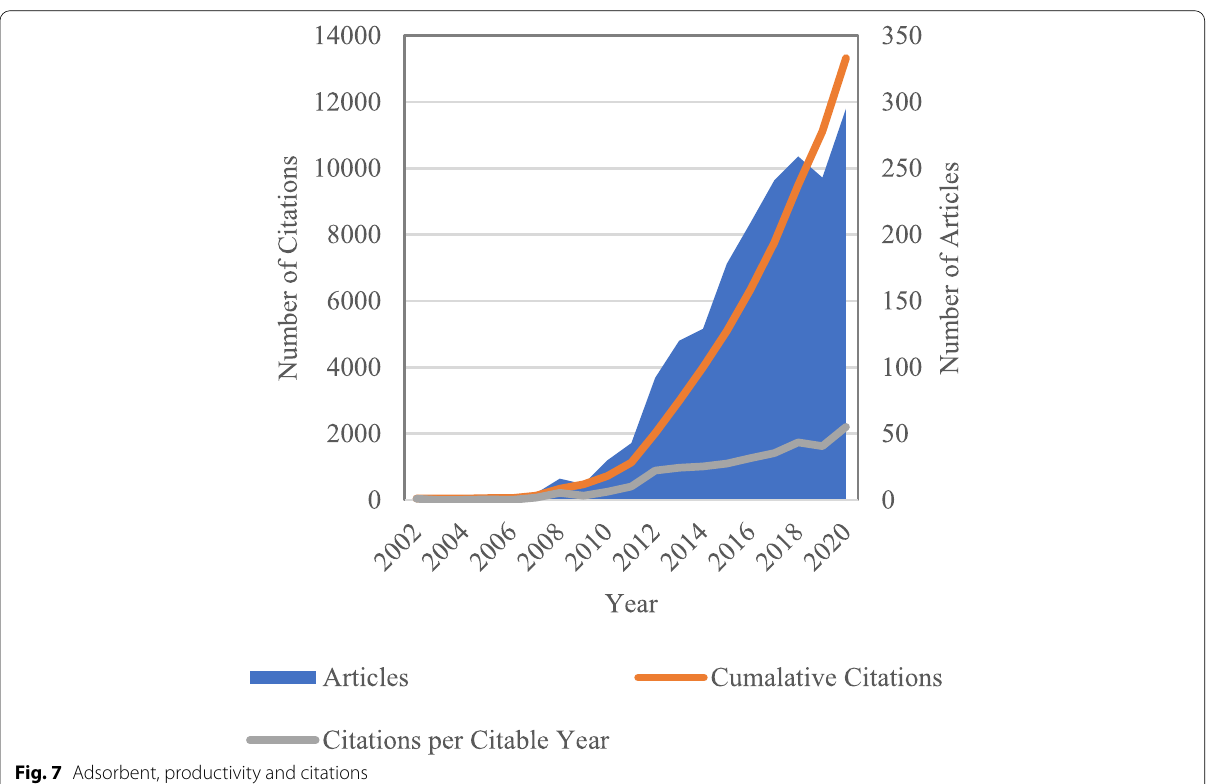
Fig. 7 Adsorbent, productivity and